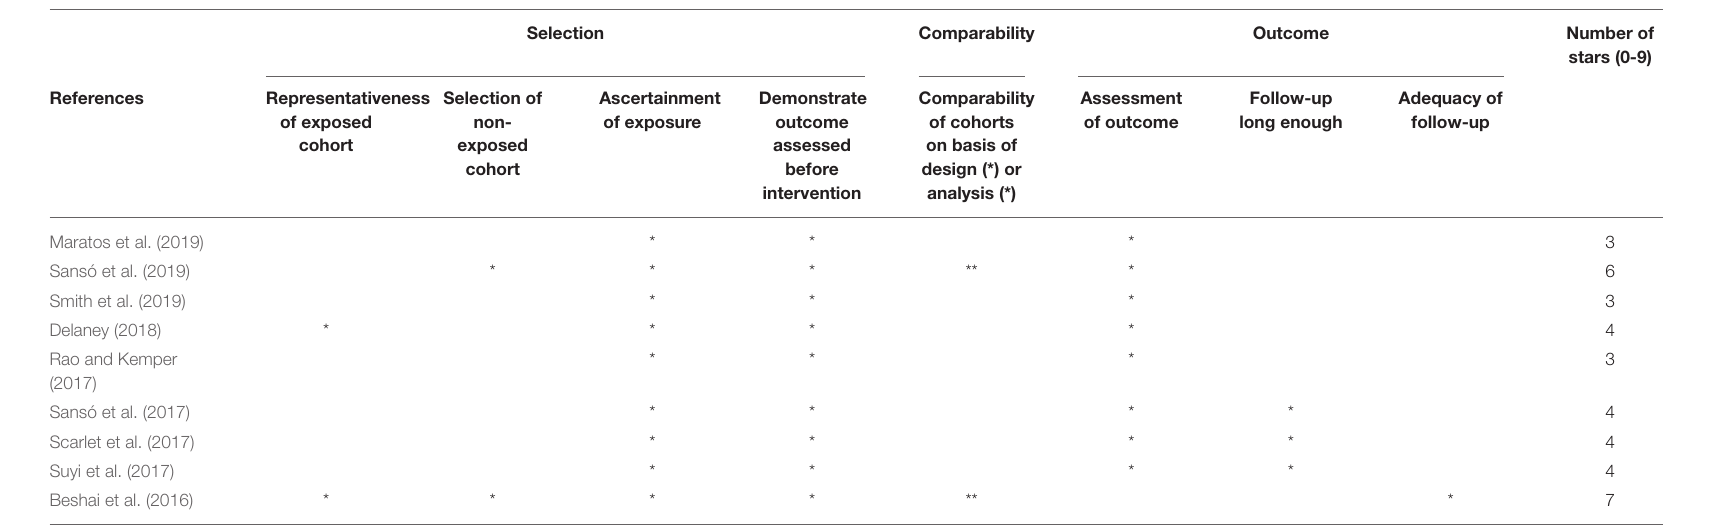
TABLE 4 | Assessment of quality of studies (non-randomized trials; nine